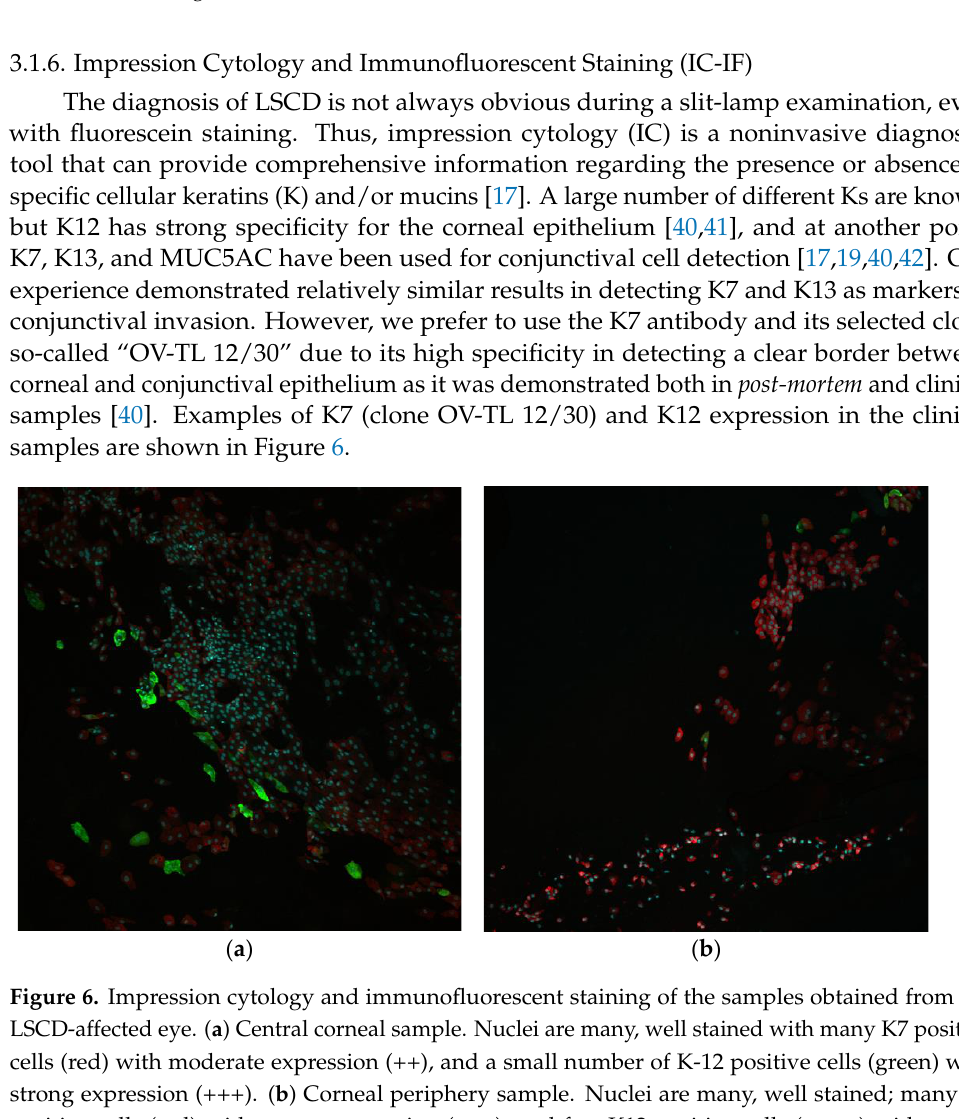
Figure 5. In vivo confocal microscopy of the patient with partial unilateral LSCD. ( a ) Confocal image of epithelial basal cells at the central cornea of the LSCD-affected eye. Wing cells are morphologically abnormal, intercellular borders are not well-defined. ( b ) Confocal image of limbal epithelium and the palisades of Vogt of the LSCD-affected eye. Absent are the palisades, and the structures of the limbus are severely damaged. ( c ) Confocal image of epithelial basal cells at the central cornea 10 months after G-SLET. Normal appearance of the wing cells having dark cytoplasm, well-defined and bright borders, and no visible nuclei. ( d ) Limbal micro-transplant (white asterisk) located inside the corneal tunnel and surrounded by the wing cells with well-defined bright borders in patient 6 months after G-SLET. ( a – d ) Image size 400 × 400 microns.